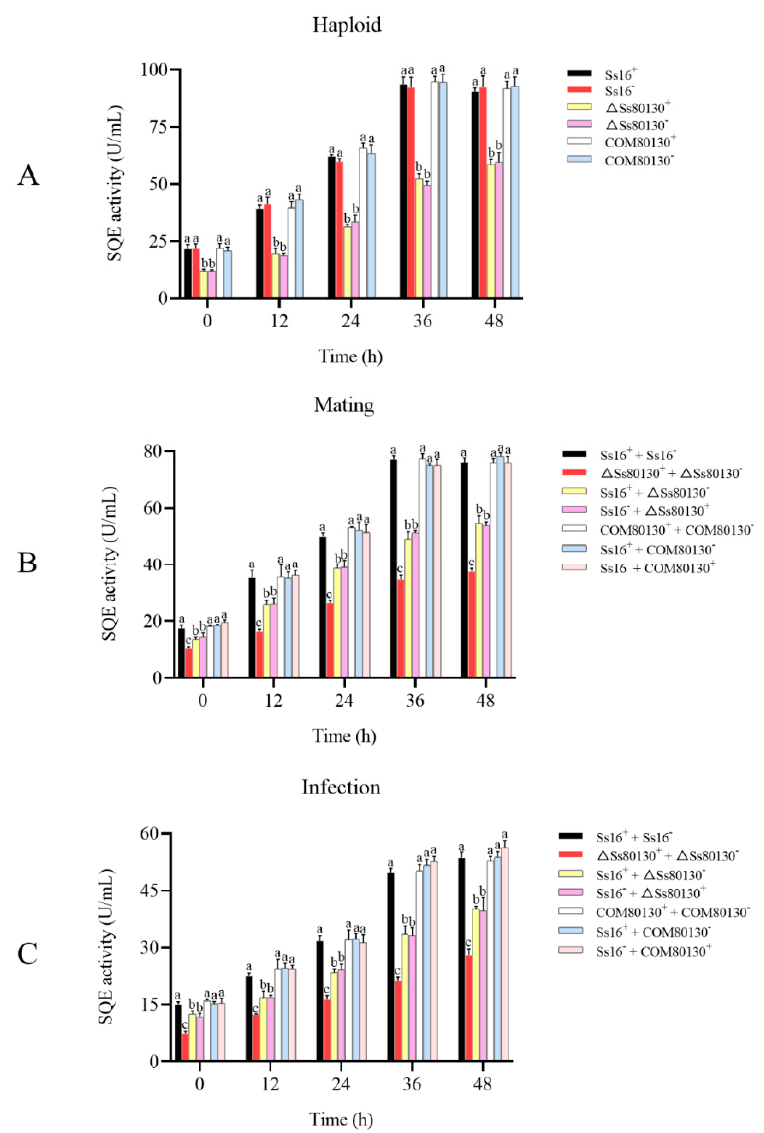
Figure 5. Effects of the SsCI80130 gene on SQE activity. ( A ) SQE activity during haploid sporidial culture. ( B ) SQE activity during sexual mating culture. ( C ) SQE activity during sugarcane bud infection. Bars indicate the standard error, and different lowercase letters represent a difference at the 0.05 level.